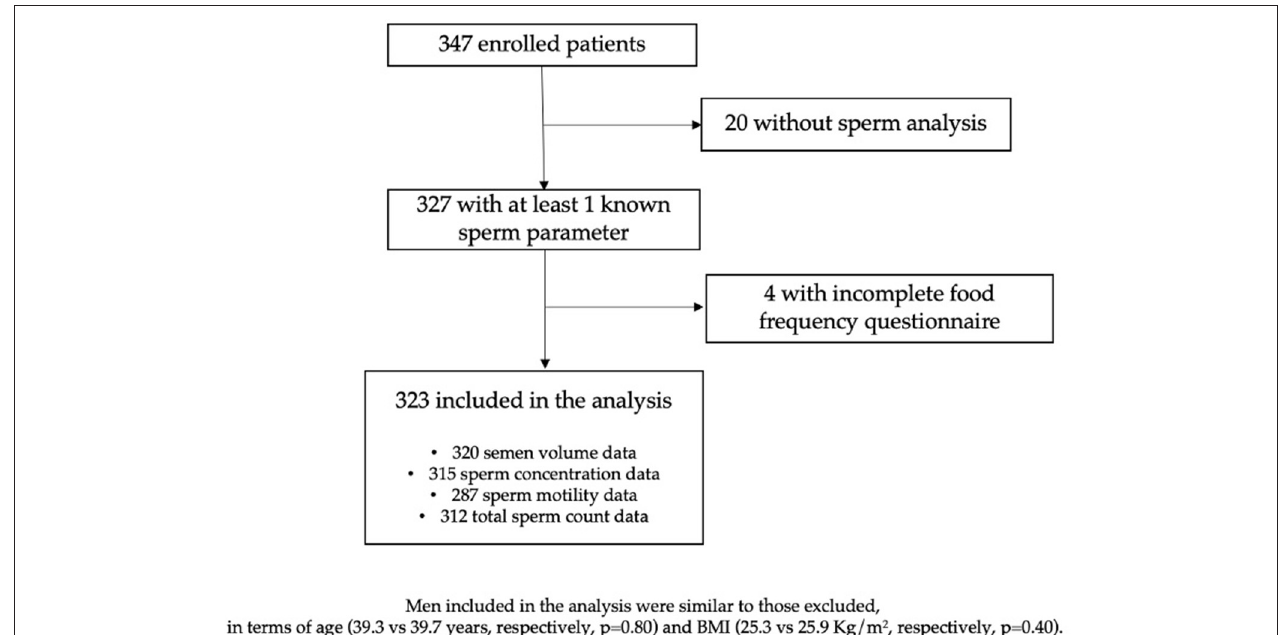
FIGURE 1 | Flow chart of enrolled patients and reasons for